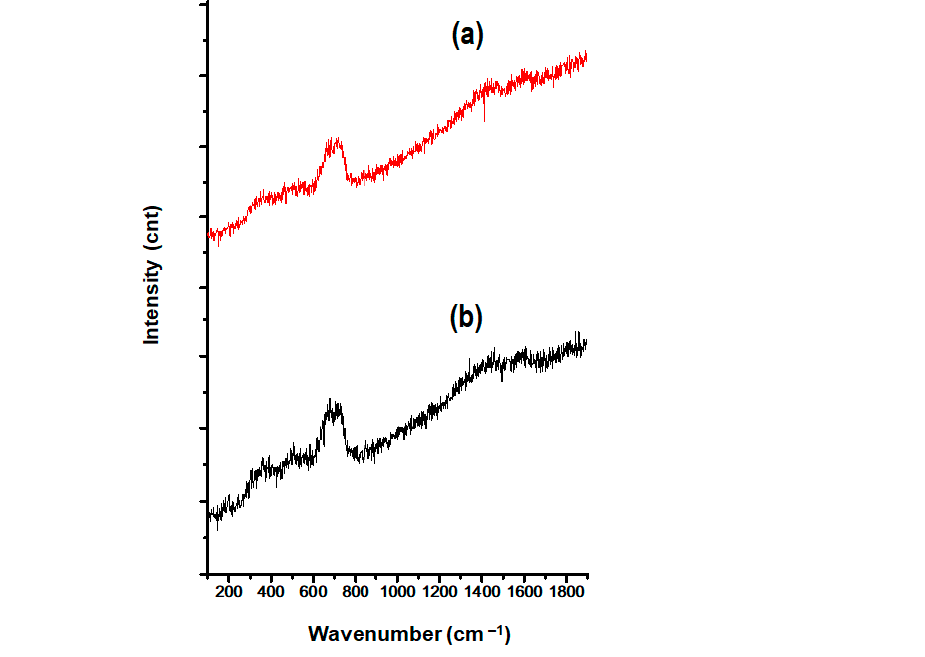
Figure 5. Raman spectra of ( a ) pristine SPIONs and ( b ) the CLA-coated PTX-SPIONs depicting the presence and integrity of the magnetite.